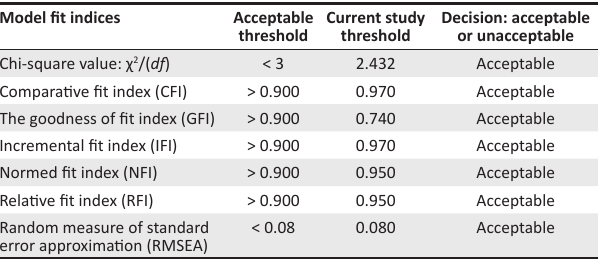
TABLE 6: Hypotheses, path coefficients, t -statistics and